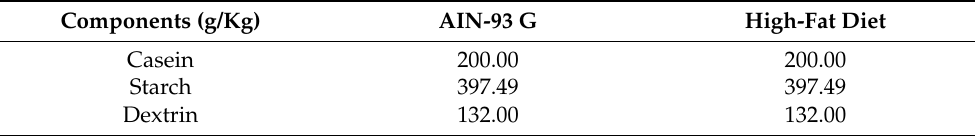
Table 1. Composition of the high-fat diet (20% lipid) prepared at the Experimental Nutrition Labora- tory, Department of Nutrition, at the Fluminense Federal University, compared to the formulation proposed by the American Institute of Nutrition for adequate feeding of rats in the growth, pregnancy, and lactation phase